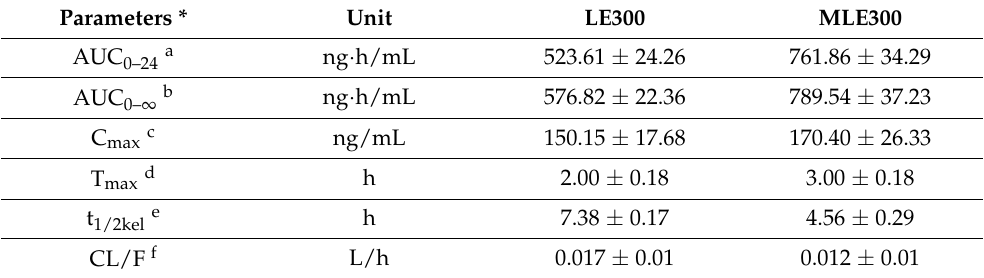
Figure 6. Concentration vs. time profile of LE300 and MLE300 in rat plasma after LE300 (10 mg/kg) oral administration. Each data represents the mean ± SD of six rats. Table 7. Pharmacokinetic parameters of LE300 and MLE300 after a single oral dose (10 mg/kg) in rat.